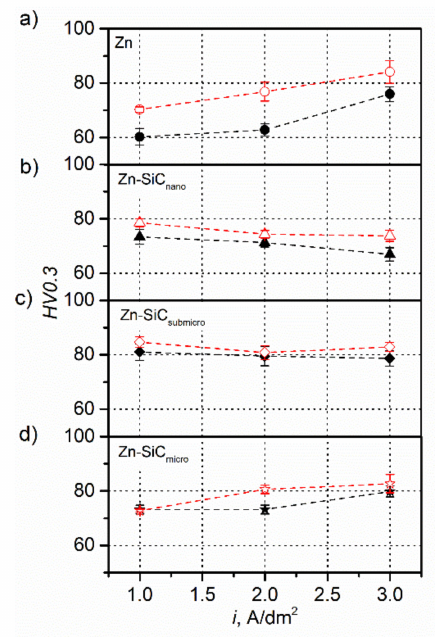
Figure 5. Hardness (HV0.3) of deposited coatings: ( a ) Zn, ( b ) Zn-SiC nano , ( c ) Zn-SiC submicro , and ( d ) Zn-SiC micro (black—no ultrasound,